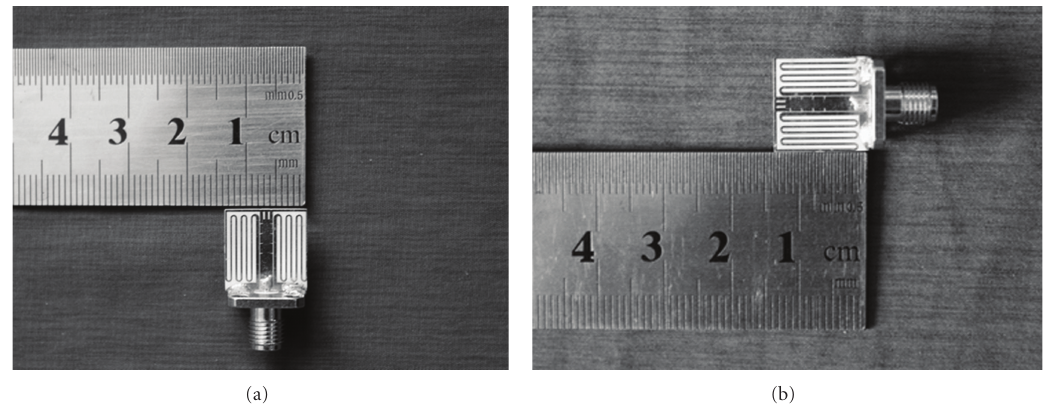
Figure 7: The prototype of the proposed antenna (a) top view (b) side view.